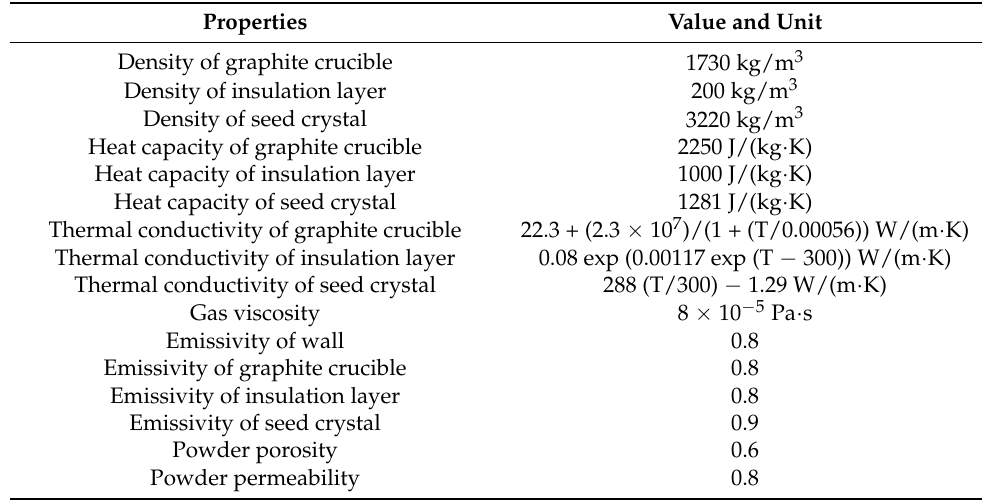
Table 1. Major physical properties and operating parameters in the